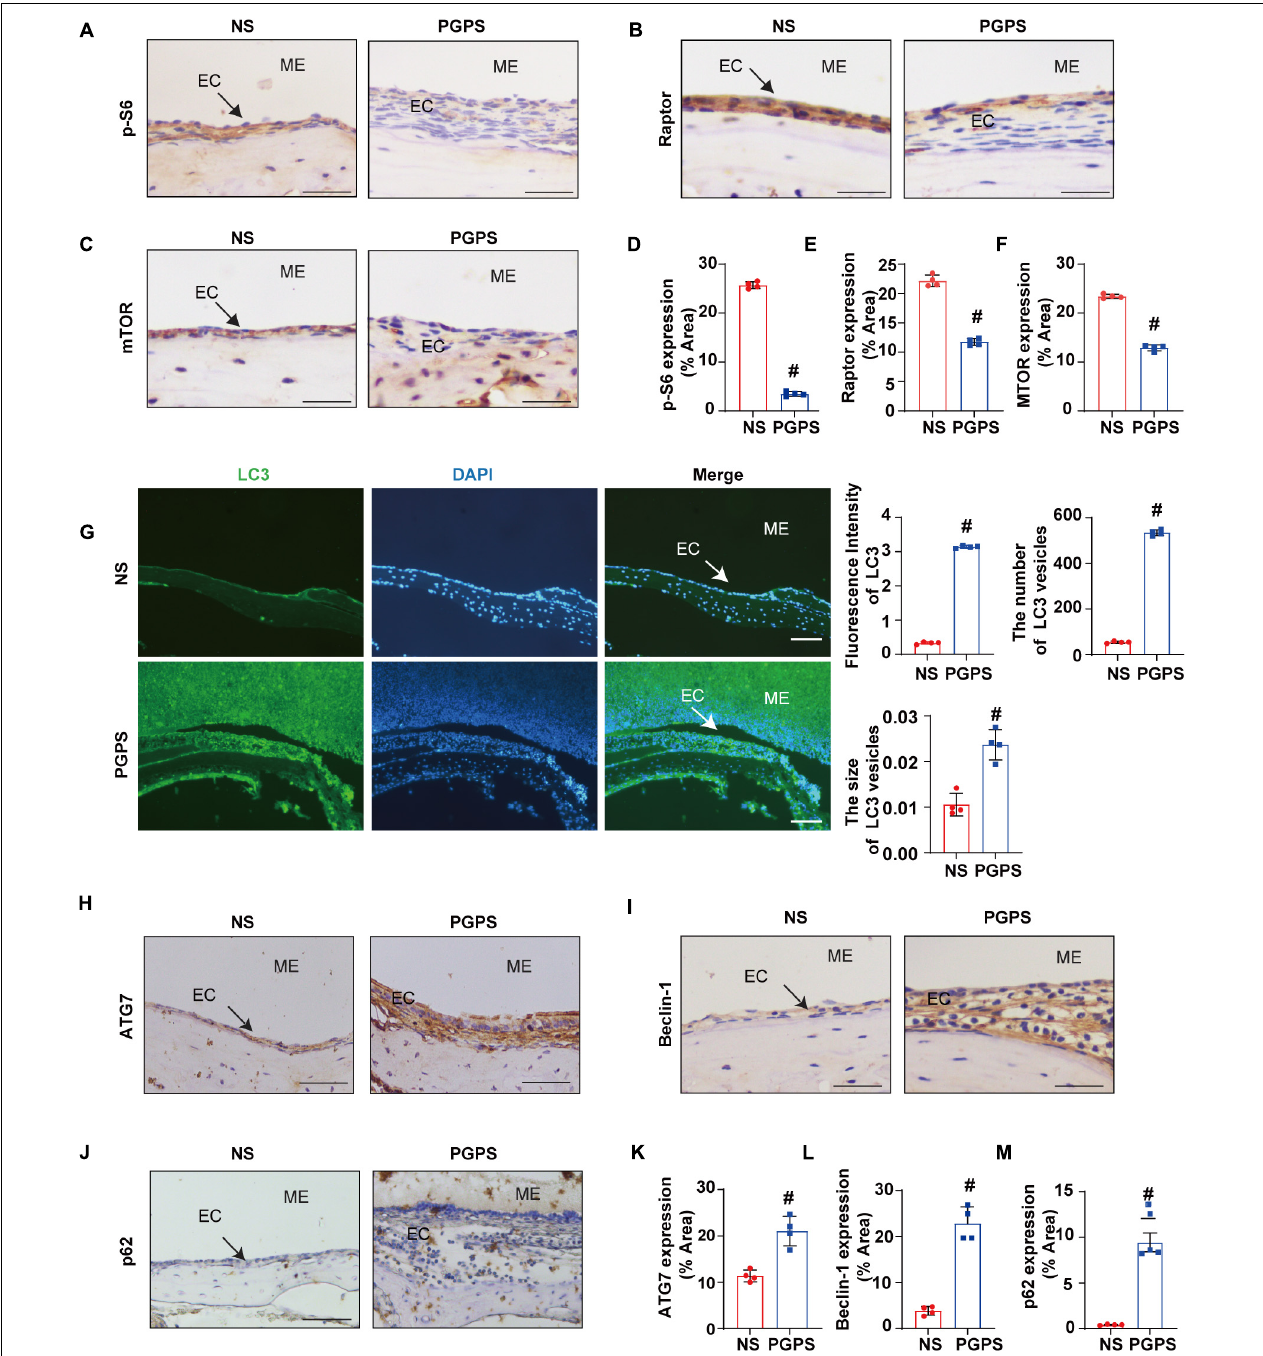
FIGURE 3 | Peptidoglycan-polysaccharide induces autophagy impairment in OM mice. Mice were inoculated with NS or PGPS for 3 days. Paraffin-embedded sections of ME tissues were immunostained with antibodies. (A) The representative images of p-S6 expression in ME tissues. (B) The representative images of Raptor expression in ME tissues. (C) The representative images of mTOR expression in ME tissues. (D) The quantification of p-S6 expression in ME tissues. (E) The quantification of Raptor expression in ME tissues. (F) The quantification of mTOR expression in ME tissues. (G) The representative images of LC3 expression, as well as quantitative images of the fluorescence intensity of LC3 protein expression and quantitative images of the size and number of LC3 vesicles. (H) The representative images of ATG7 expression in ME tissues. (I) The representative images of Beclin-1 expression in ME tissues. (J) The representative images and quantification of p62 expression in ME tissues. (K) The quantification of ATG7 expression in ME tissues. (L) The quantification of Beclin-1 expression in ME tissues. (M) The quantification of p-62 expression in ME tissues. # P < 0.05 vs. NS group, n = 4 per group, Student’s t -test. ME represents the middle ear; EC represents epithelial cells. Scale bar = 25 µ